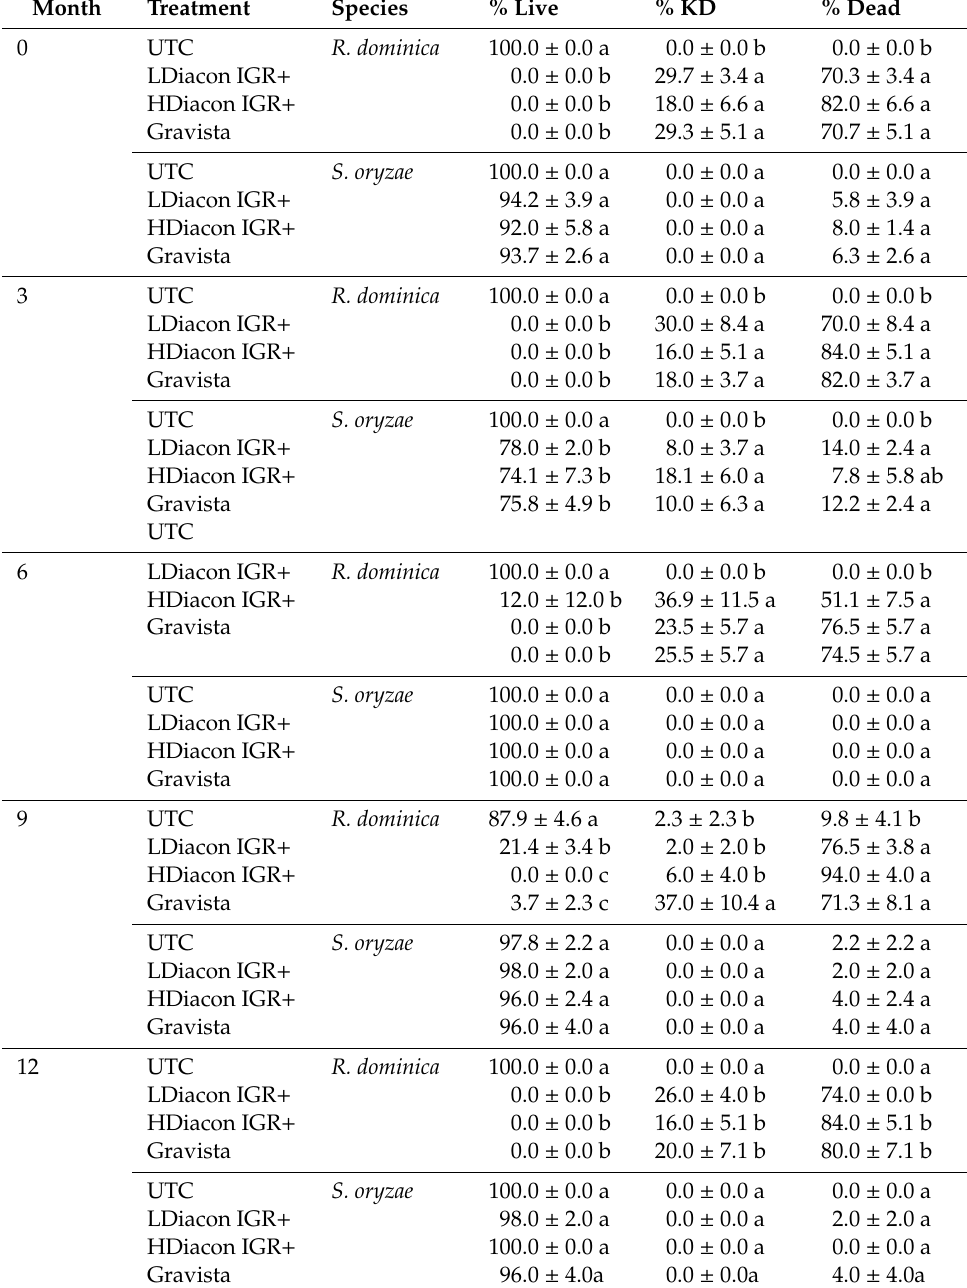
Table 12. Percentage (means ± SE) of R. dominica and S. oryzae live, knocked down (KD), or dead (means ± SE) seven days after exposure on untreated brown rice (UTC) or brown rice treated with 0.5 ppm (1.5 ppm D + 2.5 ppm M), or the Gravista (methoprene (M) + deltamethrin (D) + piperonyl butoxide synergist (PBO). Data are separated by month, bioassays were done at 0 months (1 day), and 3, 6, and 12 months after treatment 1 .